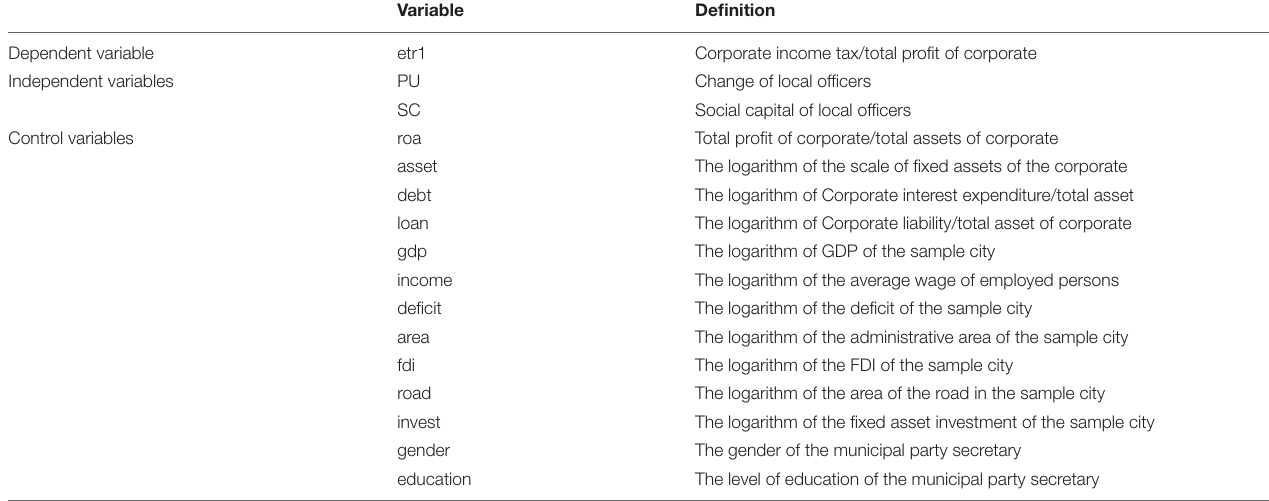
TABLE 1 | Variable definitions.